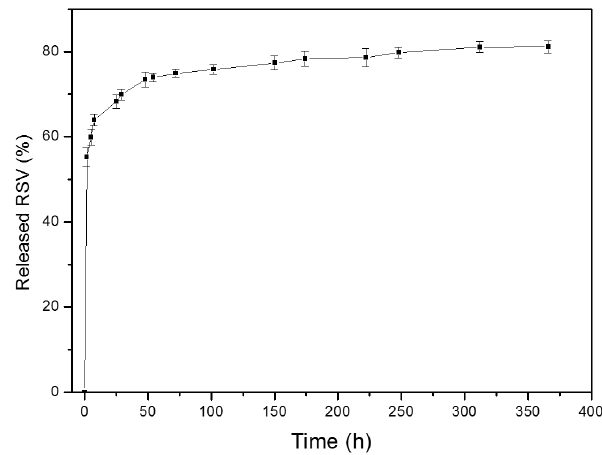
Figure 7. In vitro release profile of RSV at pH 5 and 37 °C under dark conditions.